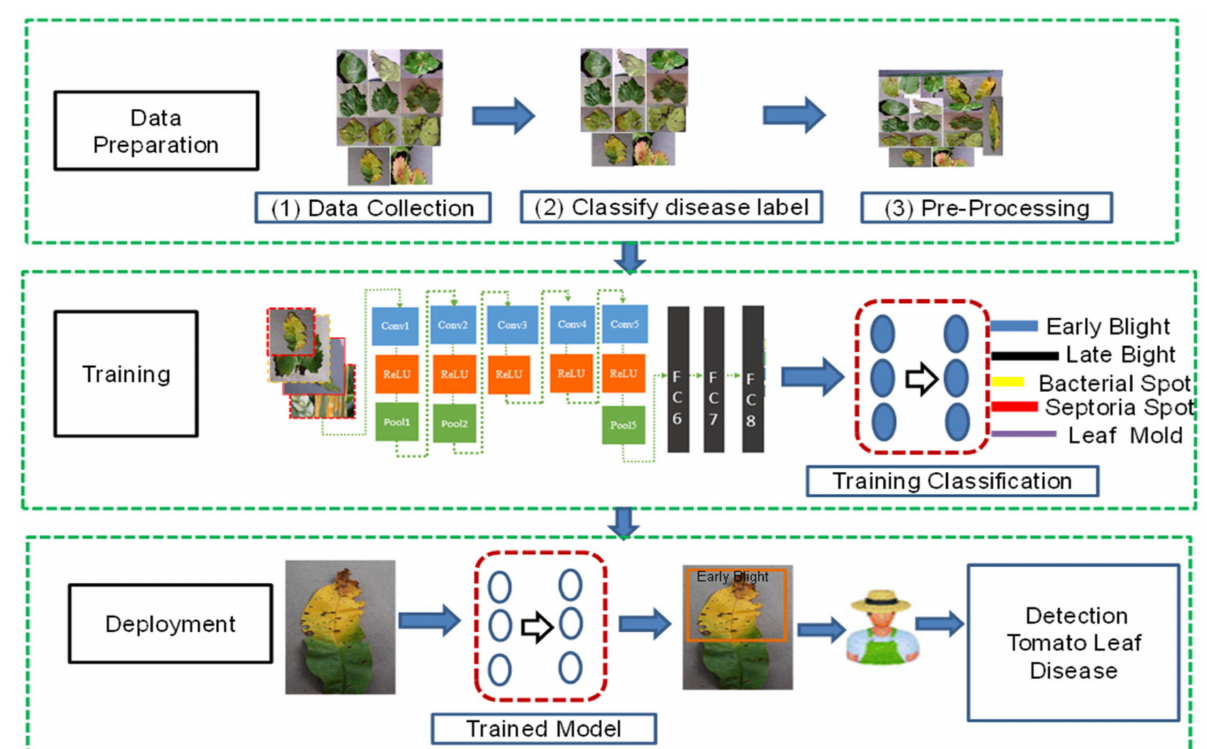
Figure 3. Proposed research framework.